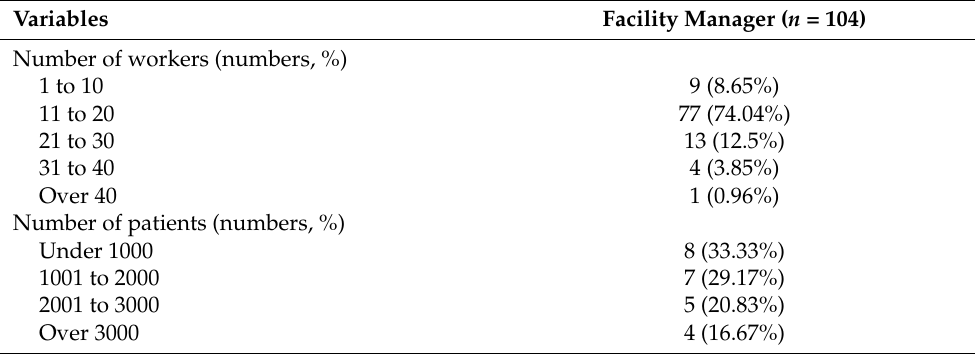
Table 2. Results of descriptive statistics of facility information responded by 104 facility